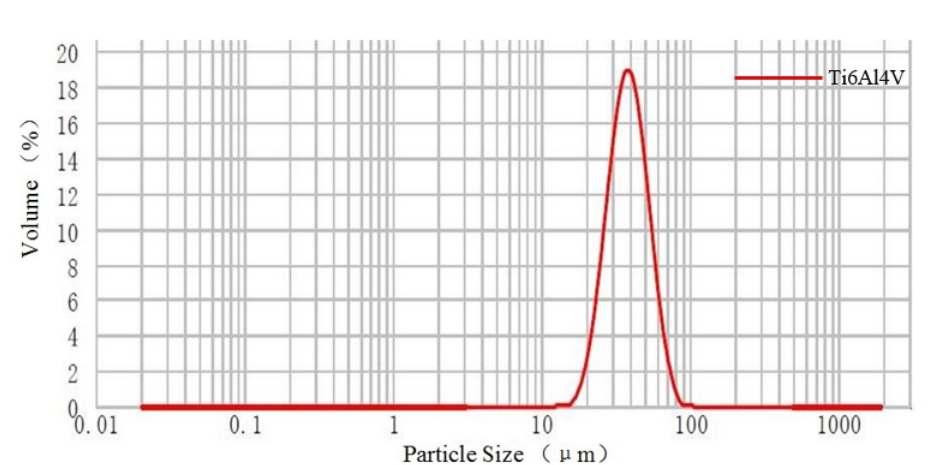
Figure 6. Particle size distribution of Ti6Al4V powder material.